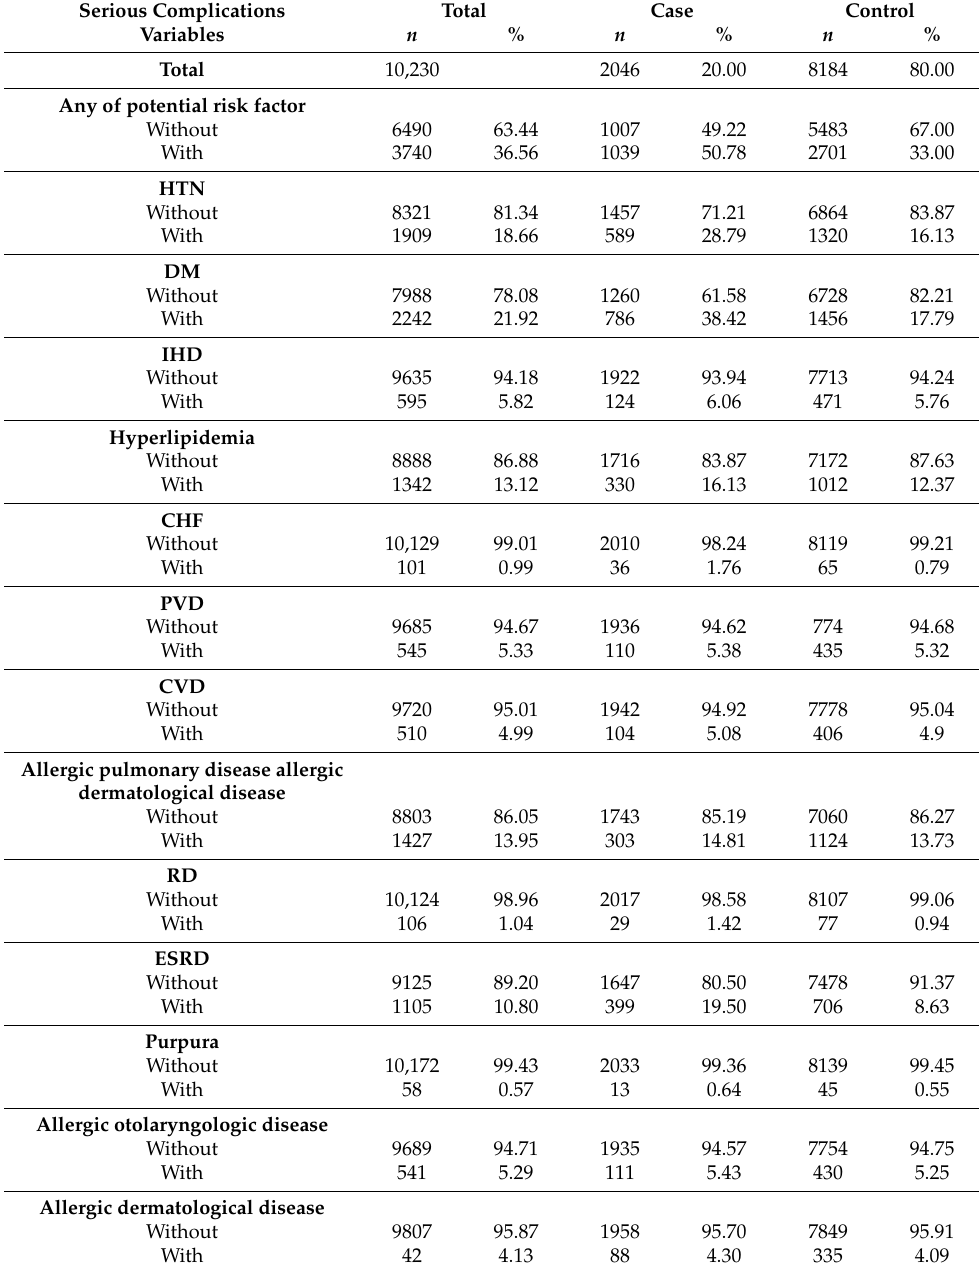
Table 3. The number of patients with or without systemic diseases one year before cataract surgery in the case and control